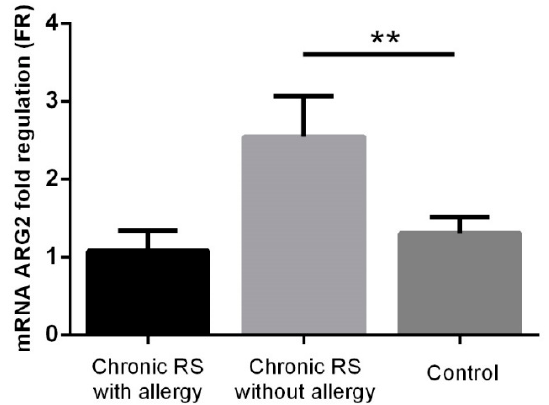
Figure 4. ARG2 expression in the group with chronic rhinosinusitis (with or without allergy) and in the control group. ** p < 0.005.